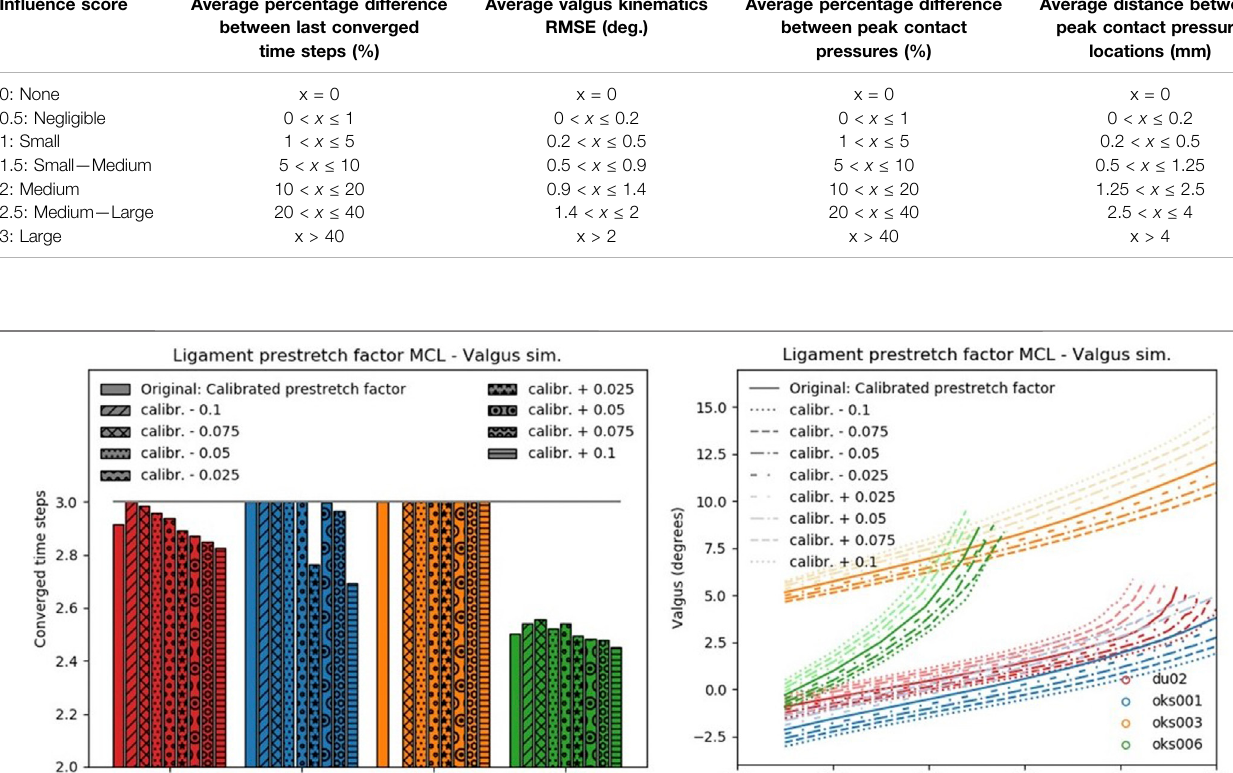
TABLE 5 | Rating scores used to qualitatively rate the in fl uence of the parameters of interest on the four model outcome parameters. In fl uence score Average percentage difference between last converged